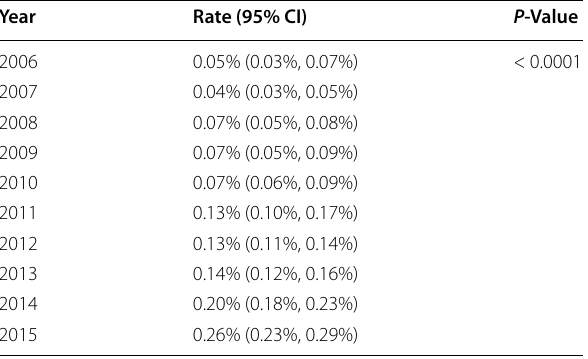
Table 1 Trend in cannabis use disorder rate by year in patients undergoing total joint